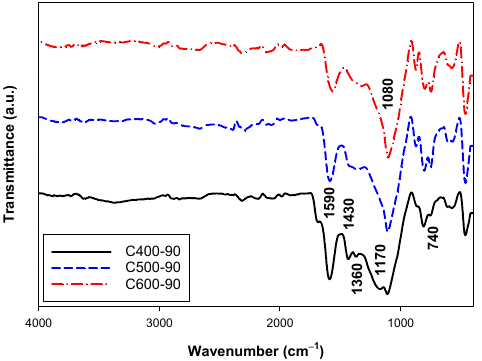
Figure 15. FTIR spectra of the prepared char. The black solid line, blue dash line, and red dash-dot line refer to char carbonized at 400, 500, and 600 ◦ C for 90